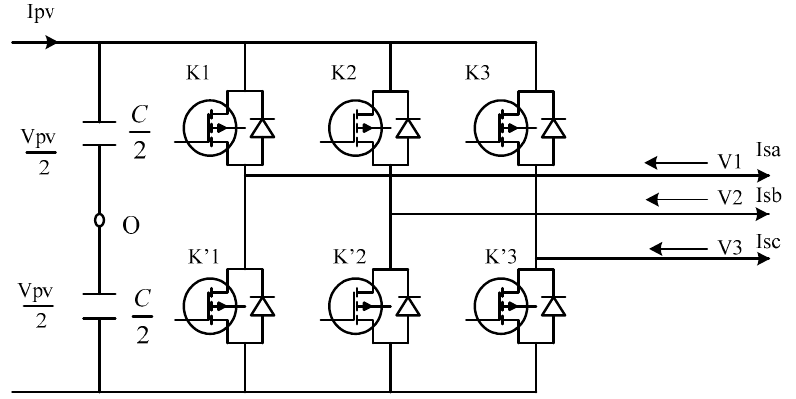
Figure 4. Three ‐ phase current inverter. Figure 4. Three-phase current